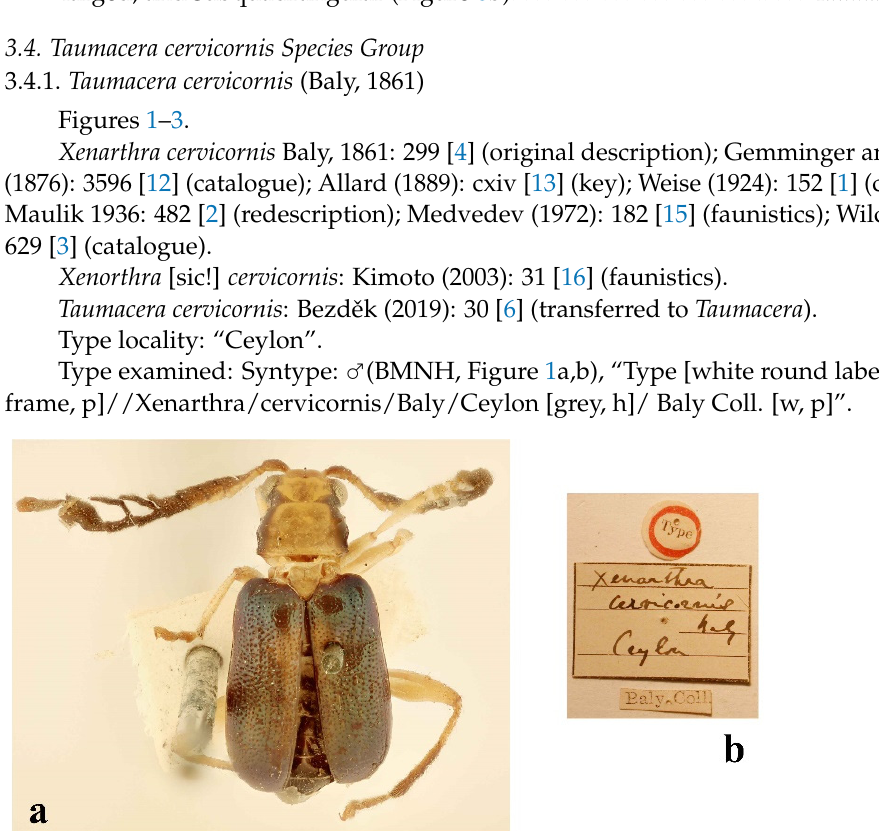
Metatarsus is modified, and metatarsomeres I and IV are distinctly enlarged. Meso- tarsomere I is triangular. Antennomeres XI and XII are unmodified. . . . . . . . . . ... 4 4 Antennomere III is gradually extended, IV–V are transverse with an inner apical margin produced in a short triangular process, and VI–IX are pectinate (Figure 14e). The mesofemora are unmodified. Metatarsomere I is axe-shaped, IV is large, sub- triangular, flat, and with an emarginated apical margin, the ventral side is concave, and claws are inserted on the ventral side of the inner apical angle (Figure 15d,e). . . . . . . . . . . . . . . . . . . . . . . . . . . . . . . . . . . . . . . . . . . ..... . . . Taumacera maskeliya sp. nov. Antennomeres III–IX are pectinate (Figure 16f). The mesofemora have a U- shaped emargination at the dorsal side near the apex (Figure 17h). Metatar- somere I is wide, and subclavate, the outer margin is nearly straight, the inner margin is widely rounded, IV is asymmetrical, enlarged, and flat, the outer margin with a rounded middle part, and the inner margin is sinuate (Figure 17k). . . . . . . . . . . . . . . . . . . . . . . . . . . . . . . . . . . . . . . . . . . . . . ... . . . Taumacera sigiriya sp. nov. The dorsal side of the body is pale brown with black spots. . . . . . . Taumacera mirabilis The dorsal side of the body is uniformly pale brown. . . . . . . . . . . . . . . . . . . . . . . . . . 6 The antennae are completely pale brown (Figure 10f). Antennomere X is elongated and slightly widened (Figure 11a). . . . . . . . . . . . . . . . . . . . . . . . . .. . . . Taumacera unicolor The Last three antennomeres are black (Figure 5e). Antennomere X is strongly en- larged, and subquadrangular (Figure 6b). ………………………….… Taumacera lewisi